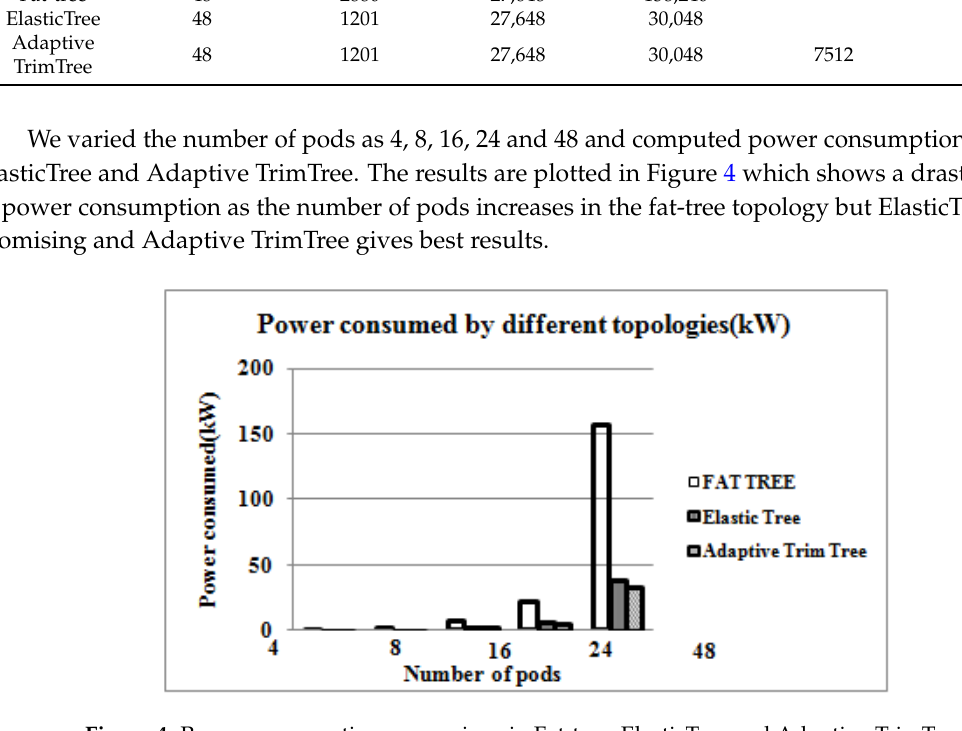
Figure 4. Power consumption comparison in Fat-tree, ElasticTree and Adaptive TrimTree.